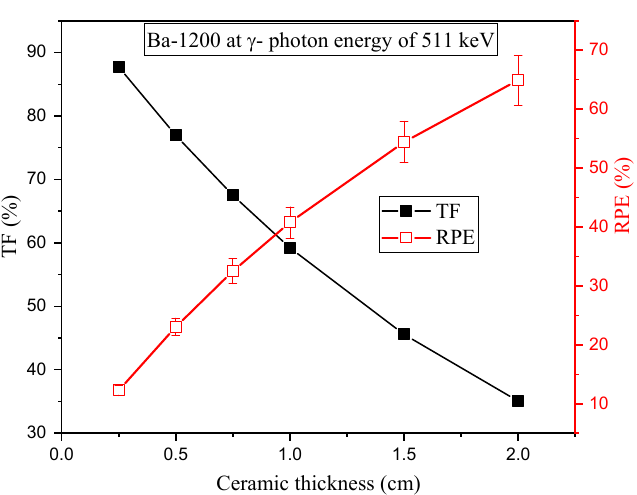
Figure 10. Influence of the thickness of the prepared samples on both the transmission factor (TF, %) and radiation-protection efficiency (RPE, %).